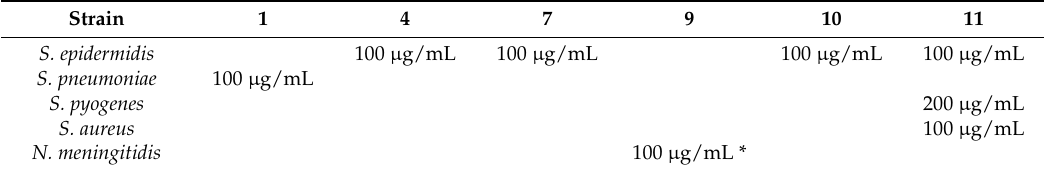
Table 3. Inhibition of growth zones (lowest effective studied concentration).